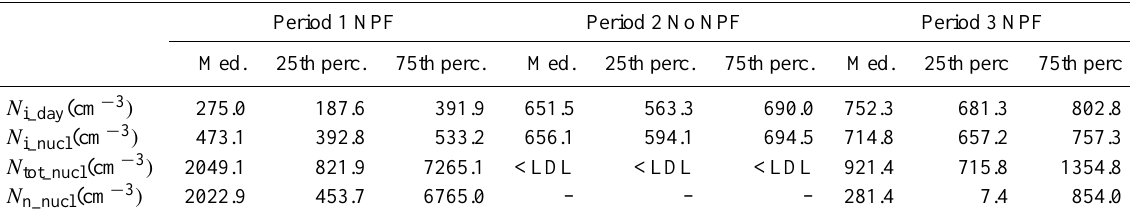
N tot_nucl (cm − 3